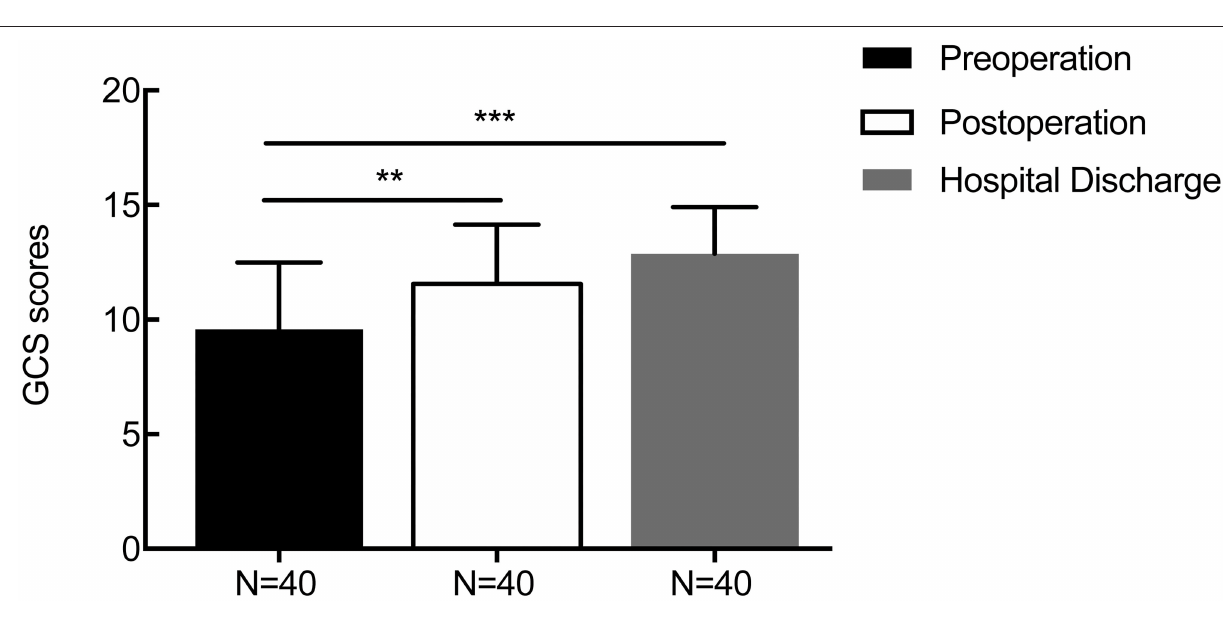
135 hospitals, including 841 patients with a basal ganglia hemorrhage, demonstrated that puncture suction is the optimal treatment when the volume of the hematoma was < 50 ml